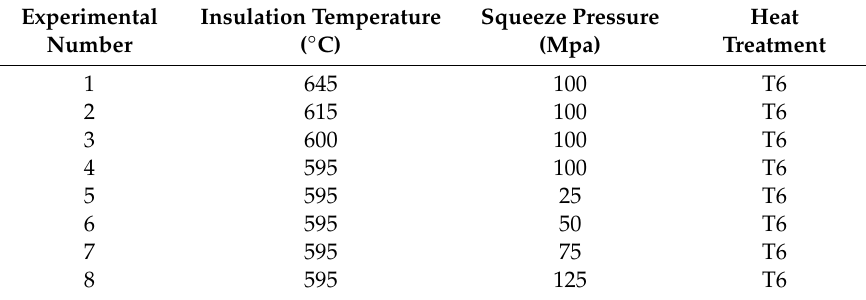
Table 2. Experimental process